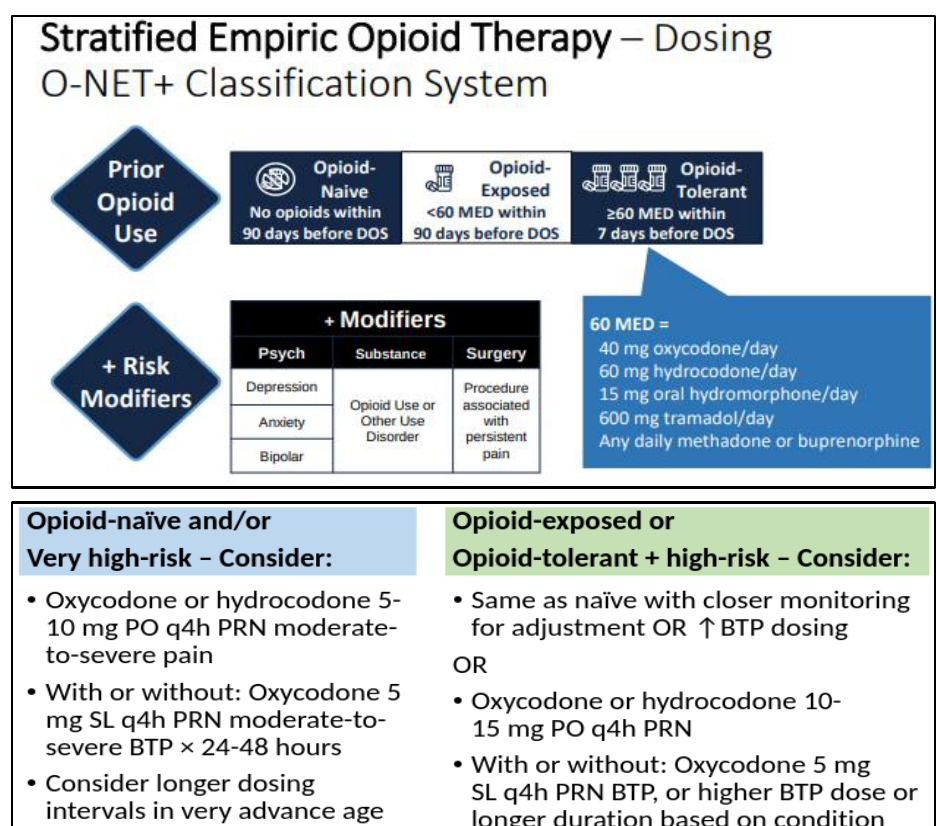
Figure 3. Framework for empiric opioid dosing considerations, based on an adaptation of the “Opioid-naïve, -Exposed, or -Tolerant plus Modifiers” (O-NET+) stratification system for risk of postoperative opioid related adverse events in patients on preoperative opioid therapy [86]. Legend: Top pain describes the O-NET+ classification system based on prior opioid use and risk modifiers, and bottom pain describes a recommended risk-stratified approach to initial opioid dosing based on this classification system (see text and reference for further information). BTP = breakthrough pain, DOS = day of surgery, MED = morphine equivalent dose, PO = by mouth, PRN = as needed, SL = sublingual.